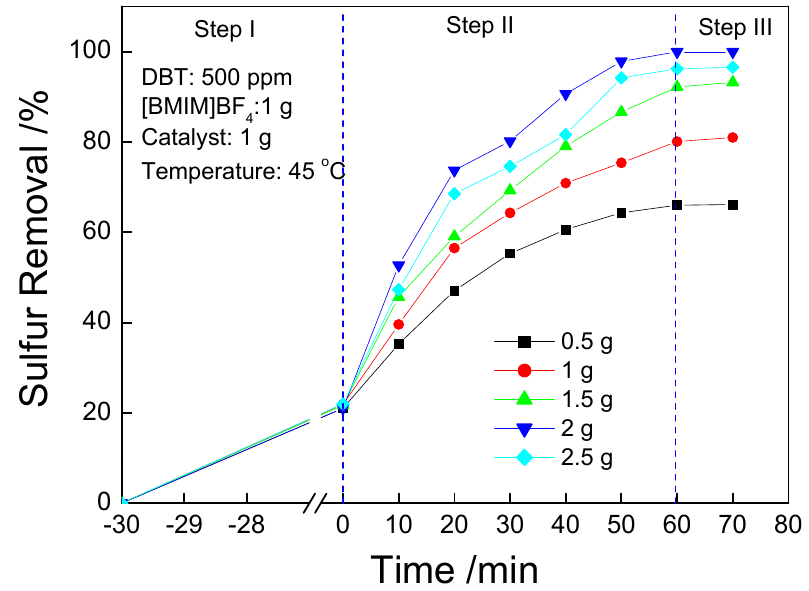
Figure 6. Effect of oxone (20 wt%) dosage.